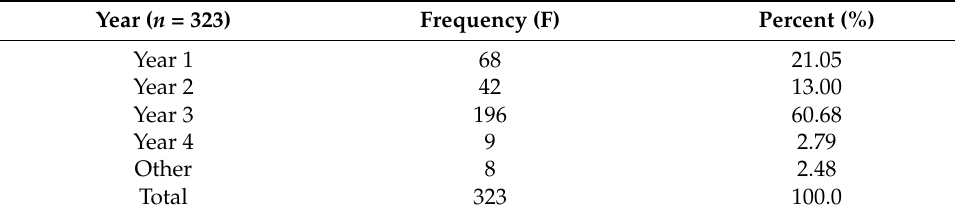
Table 5. Frequency and percentage of respondent’s year of study.